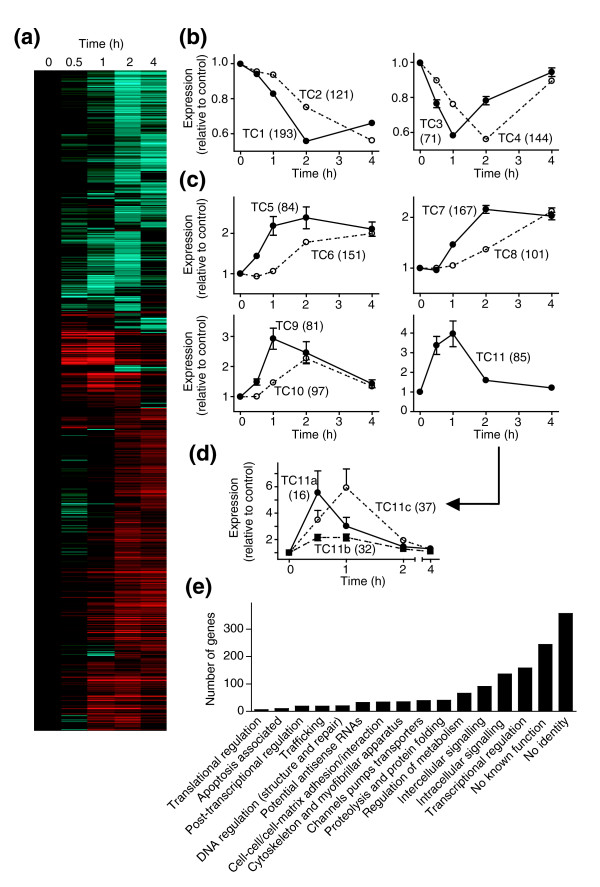
Temporal changes in RNA expression induced by ET-1 in cardiomyocytes. (a) The 1,494 probesets identified as significantly (FDR <0.05; 1.5-fold difference) up- or downregulated in response to ET-1 at 0.5, 1, 2 or 4 h were clustered using a Pearson complete correlation and are presented as a heatmap of the mean change at each time (Log10 scale: cyan = zero, black = 1, red = 6). (b,c) K means clustering generated four groups (TC1-TC4) of downregulated transcripts (b), and seven groups (TC5-TC11) of upregulated transcripts (c). The numbers of different transcripts for each group are shown in parentheses. (d) Supervised clustering of TC11 identified three subclusters (TC11a, TC11b and TC11c; numbers of transcripts in each group in parentheses) demonstrating differential temporal and transient expression before 2 h. (Note that three genes exhibited apparent increases in excess of 20-fold (Egr4, 50-fold; c-Fos, 28-fold; FosB, 306-fold) and were excluded from this clustering because of the excessive bias introduced.) Statistical significance (repeated measures one-way ANOVA with Tukey post-test) p < 0.05 for all times versus all other times except for the following (not significantly different): TC2, 0.5 versus 1 h; TC3, 0 versus 4 h and 0.5 versus 2 h; TC4, 0.5 versus 4 h; TC5, 1 versus 2 or 4 h, 2 versus 4 h; TC6, 0 versus 0.5 or 1 h; TC7, 0 versus 0.5, 2 versus 4 h; TC8, 0 versus 0.5 or 1 h, 0.5 versus 1 h; TC9, 0 versus 0.5 or 4 h, 0.5 versus 4 h, 1 versus 2 h; TC10, 0 versus 0.5 h, 1 versus 4 h; TC11, 0 versus 2 or 4 h, 0.5 versus 1 h, 2 versus 4 h. (b-d) Results are means ± SEM for the numbers of transcripts given in parentheses. (e) Classification of genes regulated by ET-1 according to known or probable function (see Additional data file 1 for details).